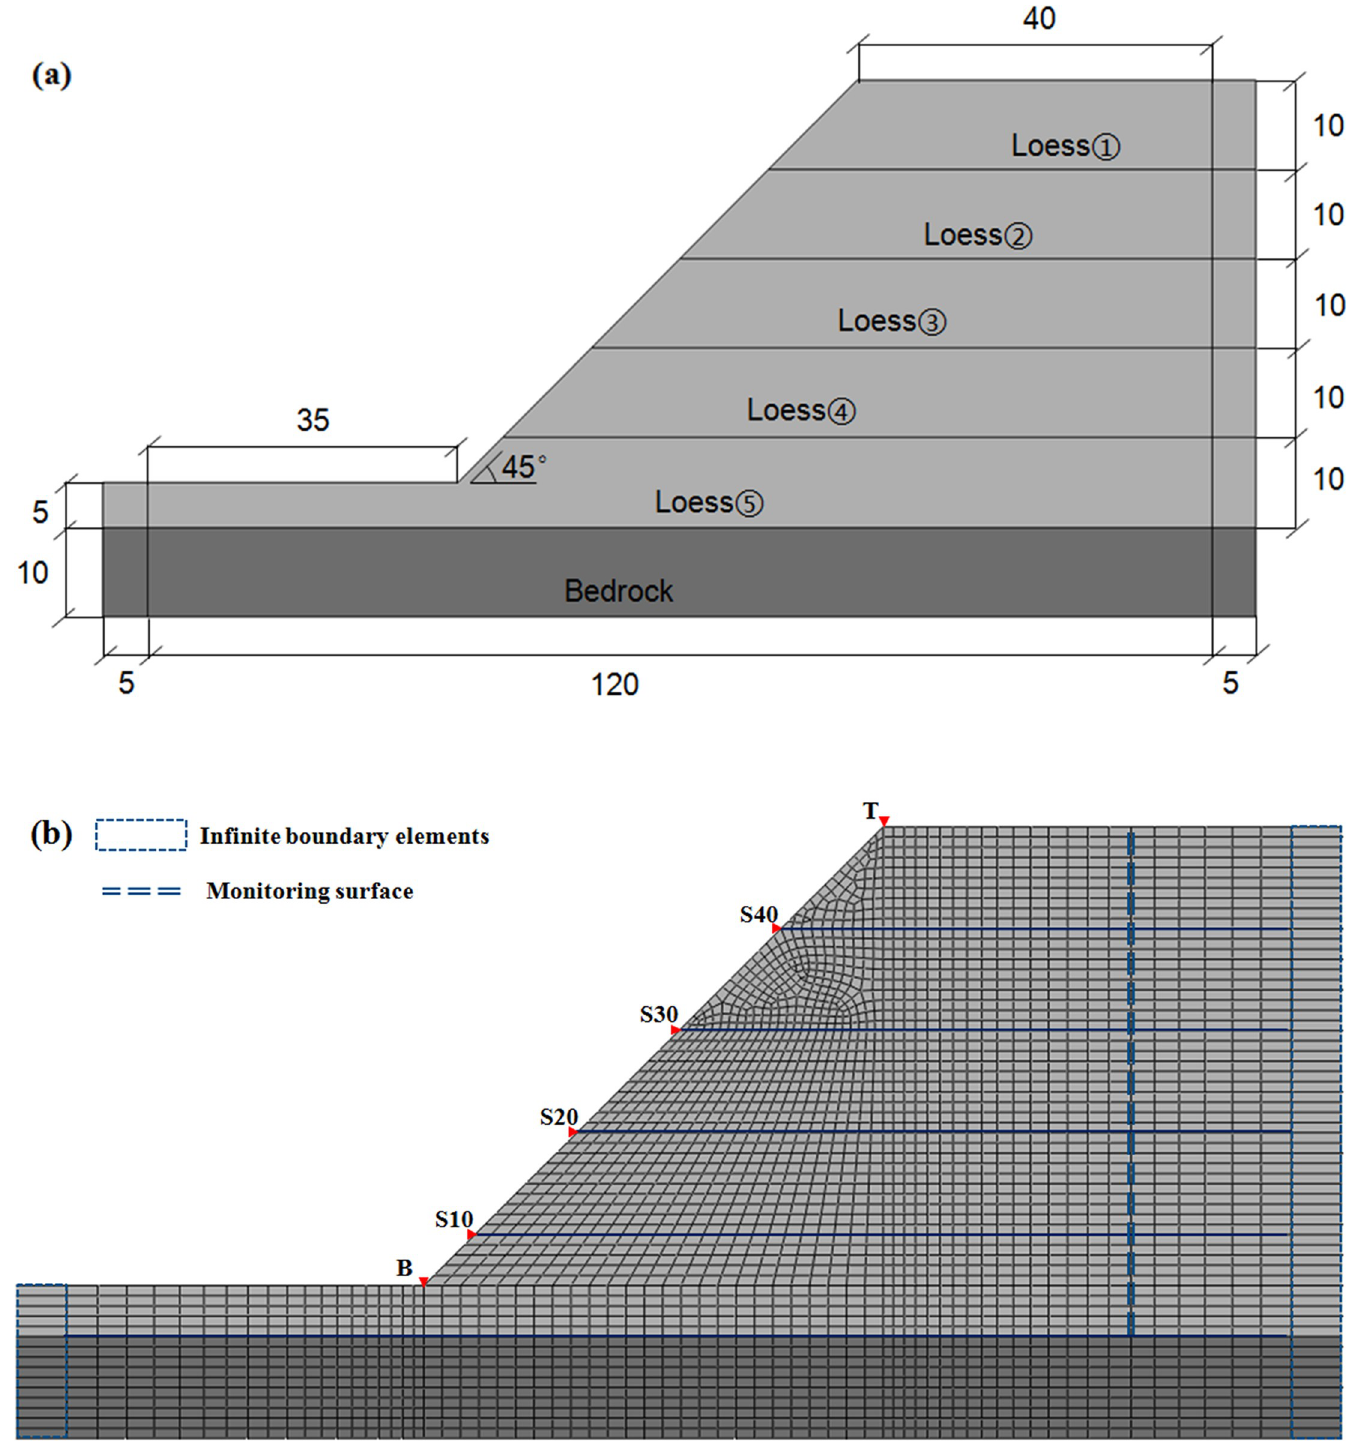
Fig 8. Models of finite element analysis: (a) Profile of the loess slope (unit: m); (b) Finite element model.